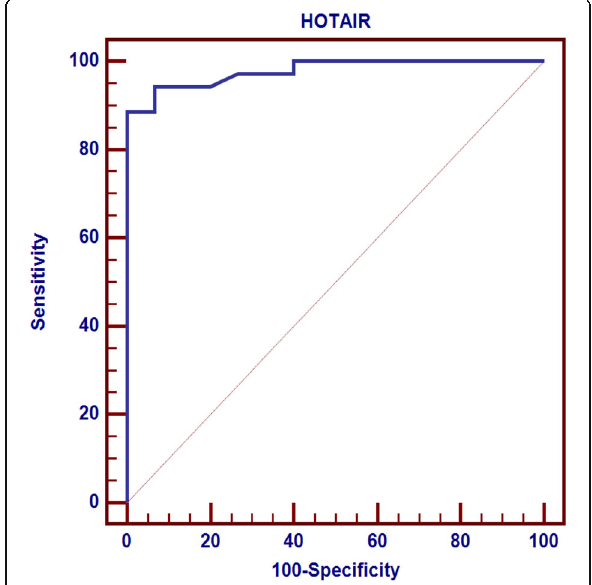
Fig. 4 Receiver operating characteristic curve (ROC) for HOTAIR to differentiate between AML patients and